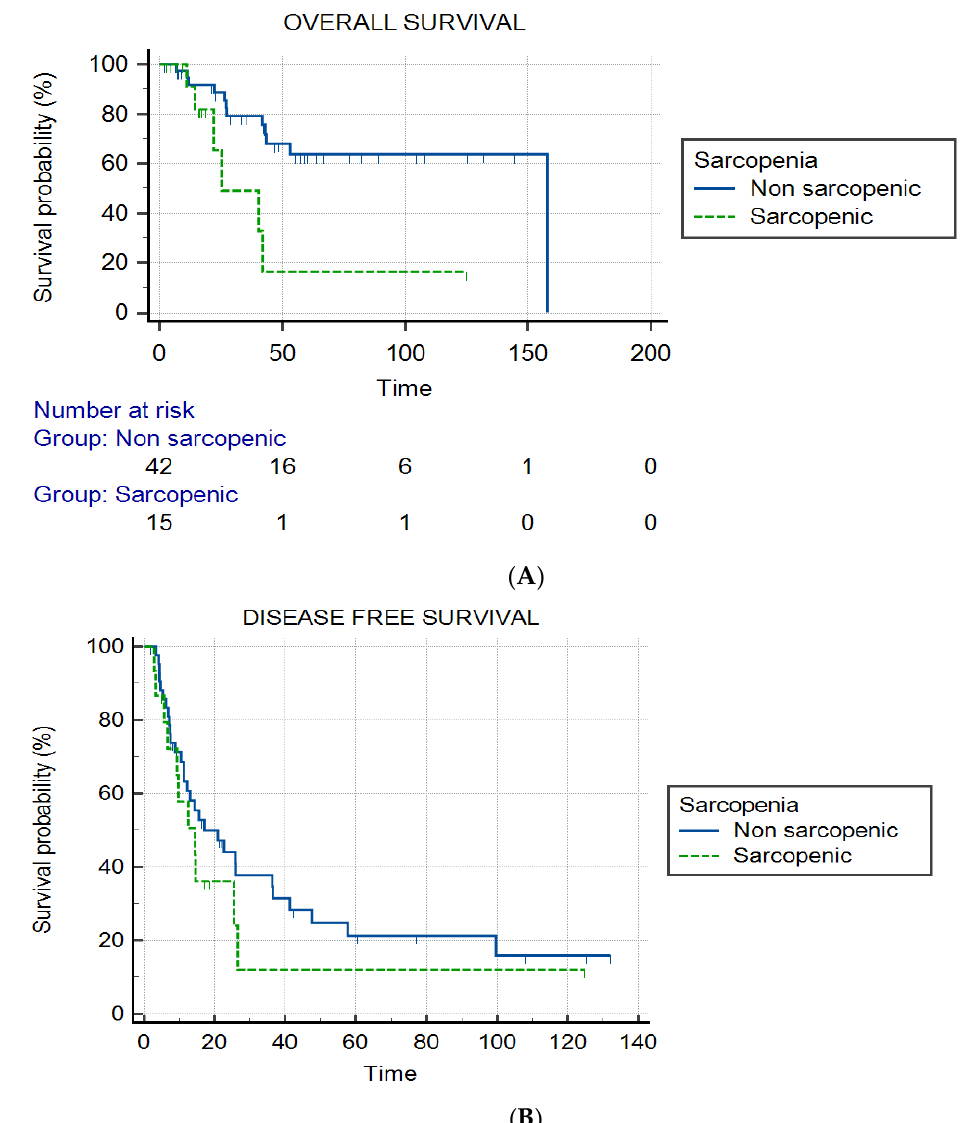
Figure 4. Graphs show Kaplan–Meier estimates of overall survival (OS) and disease-free survival (DFS) according to sarcopenia status. ( A ) Graph shows OS in sarcopenic group and non-sarcopenic group. Median OS was 25.5 months for sarcopenic patients (IQR: 14.5–41.5) vs. 157.7 months for non-sarcopenic patients (IQR: 42.5–157.7) ( p = 0.01). Hazard ratio was 6.9 (95% CI: 1.67–28.29). ( B ) Graph shows DFS in sarcopenic group and non-sarcopenic group. Median DFS was 20.9 months for non-sarcopenic patients (IQR: 7.4–47.6) vs. 14.6 months for sarcopenic patients (IQR: 6.6–25.9) ( p = 0.34). Tick marks indicate censored data. Time is expressed in months.